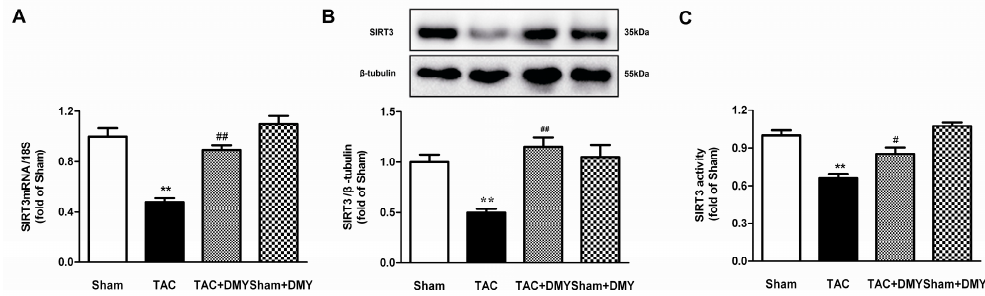
Figure 8. Effect of DMY on sirtuin 3 (SIRT3) expression in the myocardium of mice after TAC. ( A ) SIRT3 mRNA expression was quantified by real-time PCR. 18S was used as a housekeeping gene. ( B ) SIRT3 protein expression was quantified by western blot. β -tubulin was used as a loading control. ( C ) SIRT3 activity was quantified with fluorimetry. ** p < 0.01 versus Sham; # p < 0.05, ## p < 0.01 versus TAC ( n =